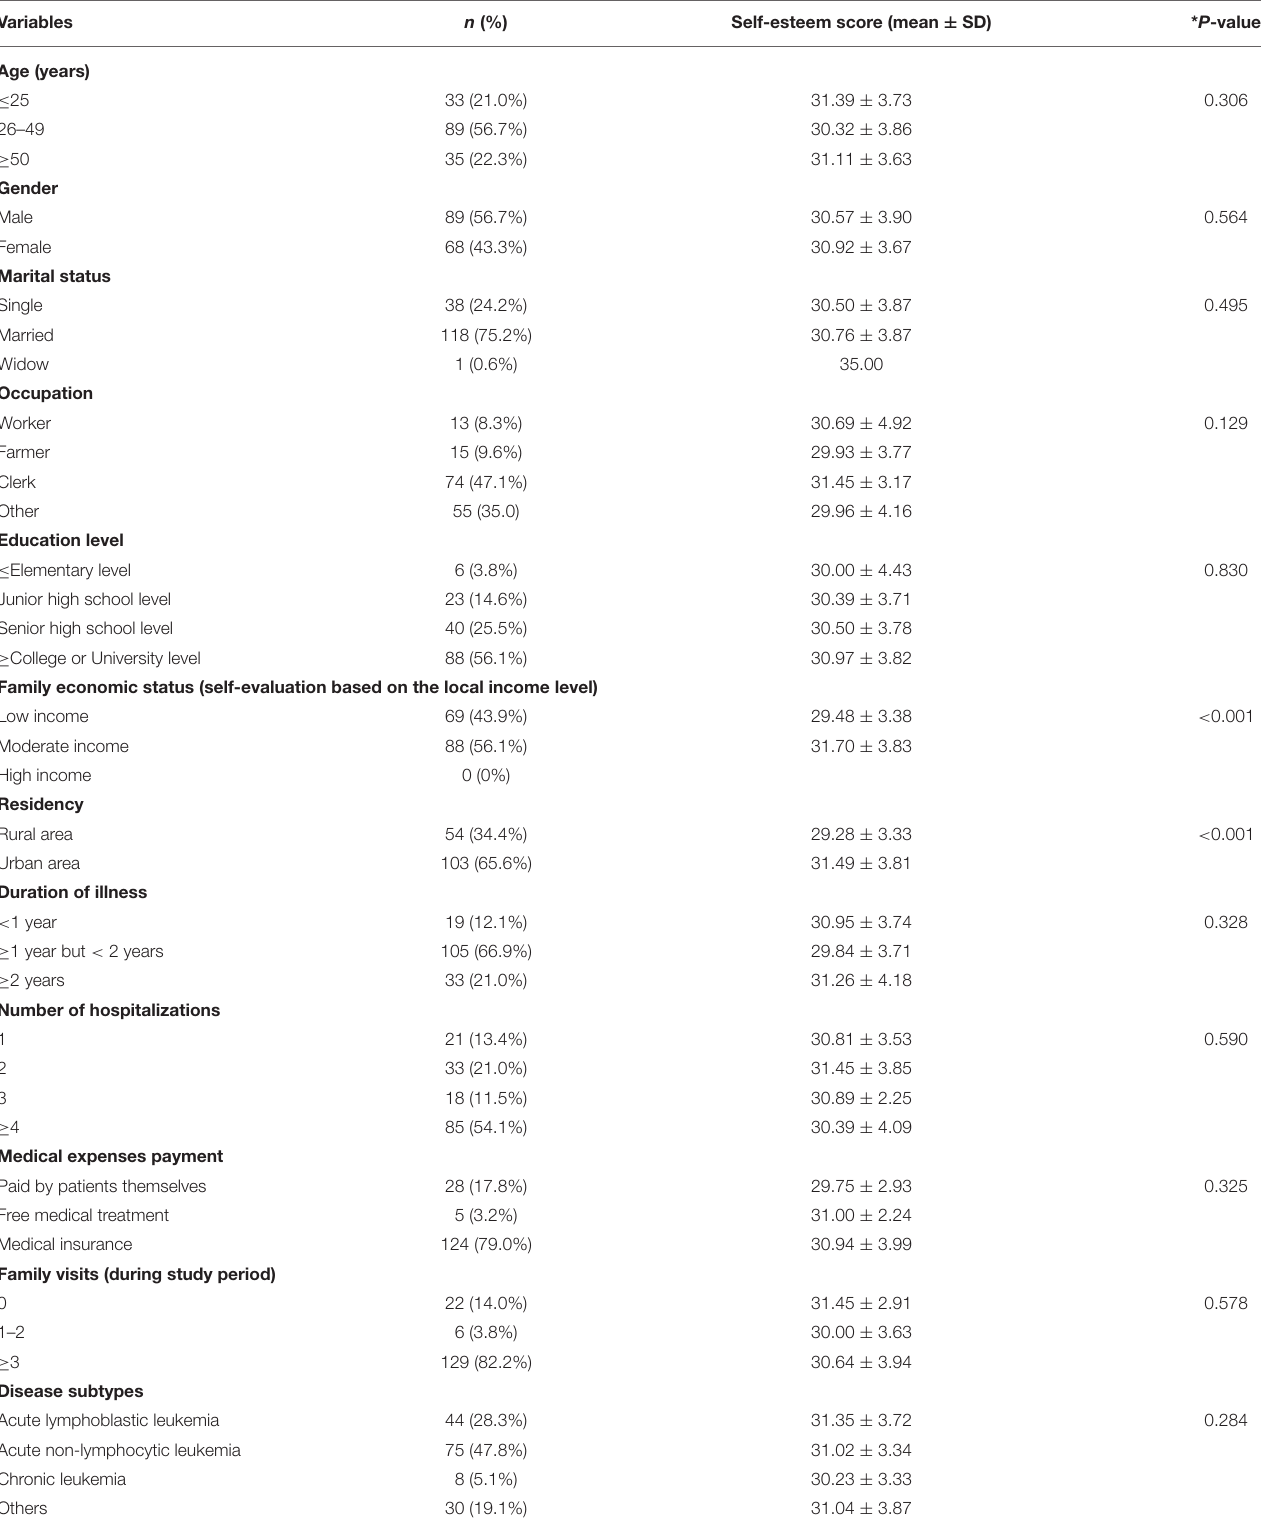
TABLE 1 | Associations between demographic characteristic and self-esteem among the 157 included patients with hematological cancers.